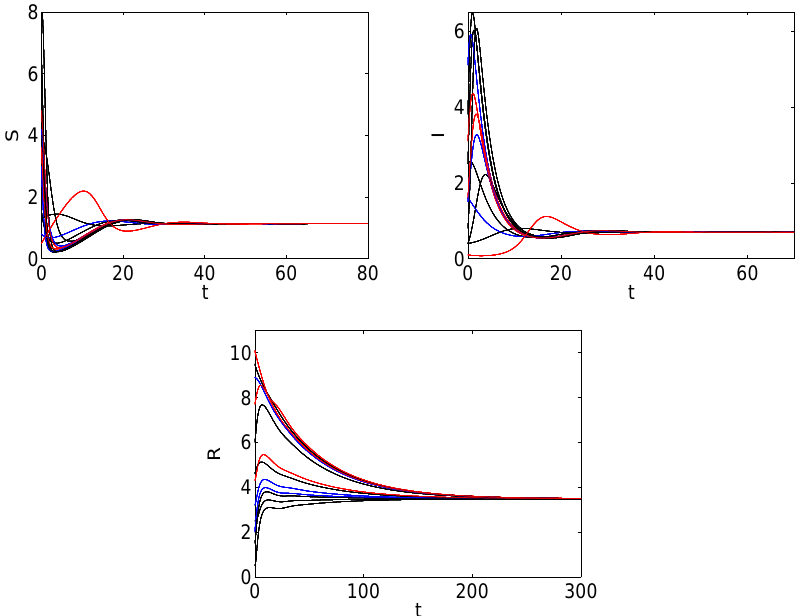
Figure 3. The reproduction number R 2 for elimination-free ( q = 0) and vaccination-free ( p = 0) model is R 2 = 11.47 > 1, the numerical simulation is shown in Figure 4. The reproduction number R 3 for elimination-free ( q = 0) and quarantine-free ( δ = 0) model is R 3 = 5.0649 > 1, the numerical simulation is shown in Figure 5.